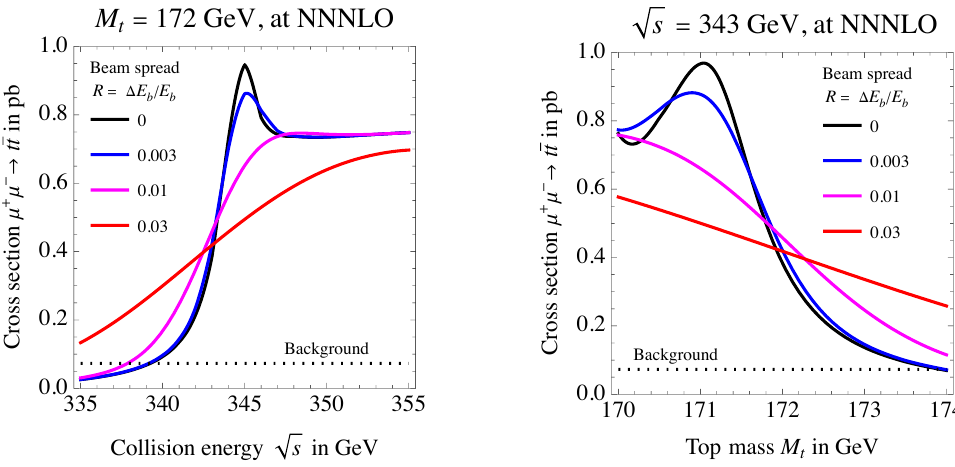
Figure 3 . Cross section for ‘ + ‘ − → t ¯ t around threshold at NNNLO accuracy and including Higgs- EW corrections, obtained with the QQbar_threshold code [47, 48]. The background estimated for the CLIC analysis in [13], of 73 fb , is reported as a dotted line. Left: as function of √ Right: as function of M t , fixed s . We here employ the ‘potential-subtracted’ top mass